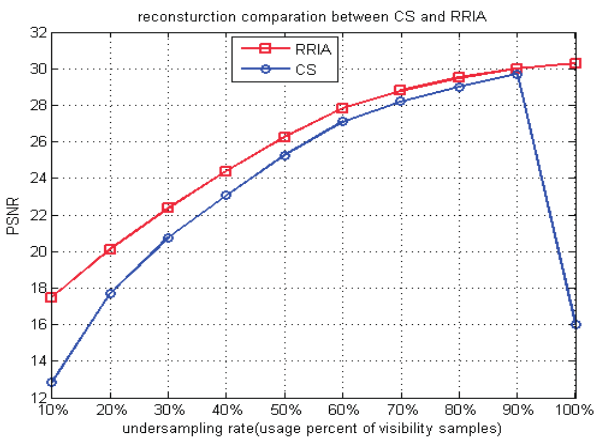
Figure 7. PSNR comparison between CS and RRIA with varying undersampling